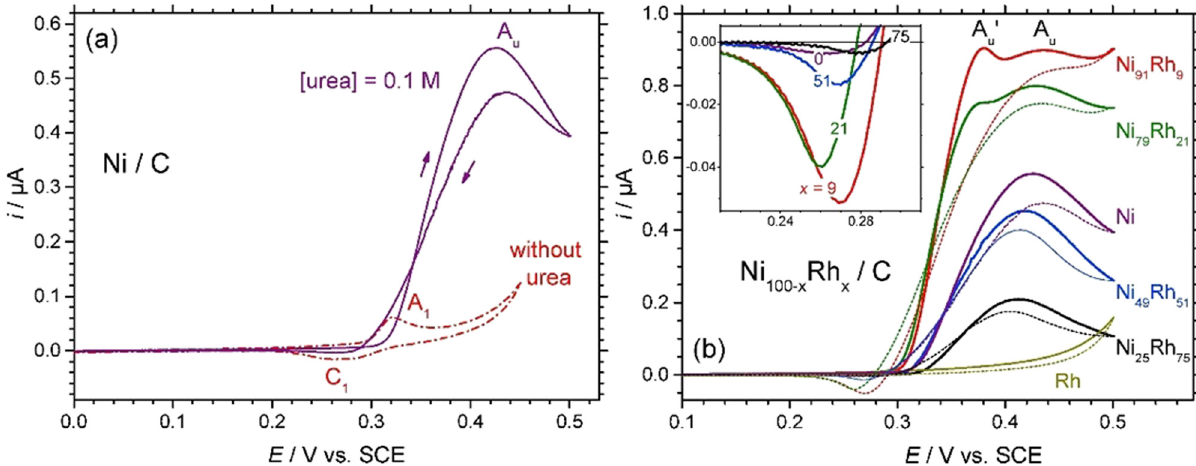
Figure 14: ( a ) Voltammograms recorded for Ni/C in KOH 1 mol L − 1 and urea 0.1 mol L − 1 , at 10 mV s − 1 . ( b ) Voltammograms of Ni 100 − x Rh x /C